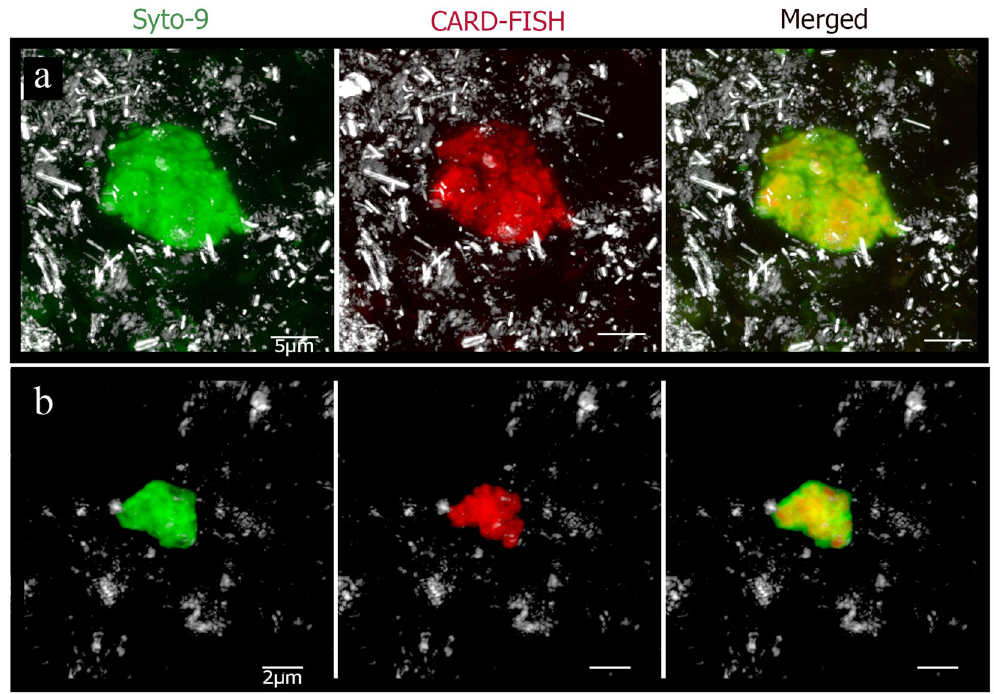
Figure 1. Detection of bacteria and archaea in subsurface drilled samples from different depths. SYTO-9 stain (green), reflection (gray) and CARD-FISH (red) of ( a ) bacteria at 420 mbs and ( b ) archaea at 496,8 mbs. Scale bars, 5 μ m ( a ) and 2 μ m ( b ).